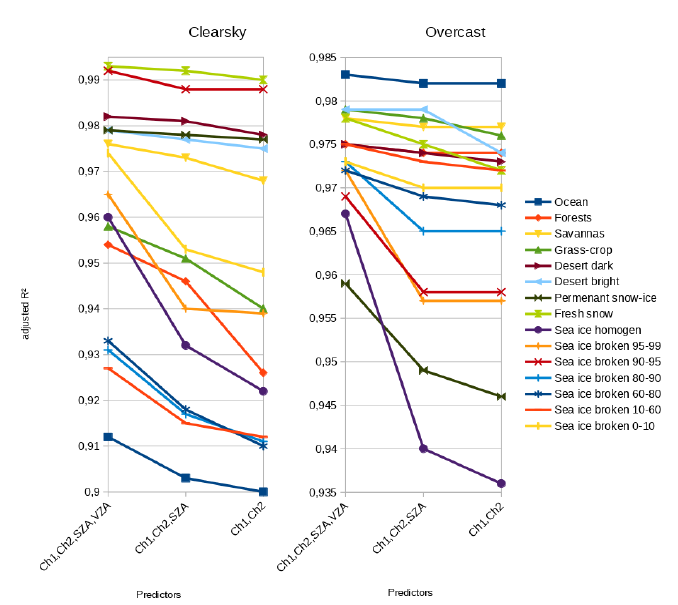
Figure A1. R 2 per scene type as function of regression predictors, for ( a ) clearsky and ( b ) adj overcast